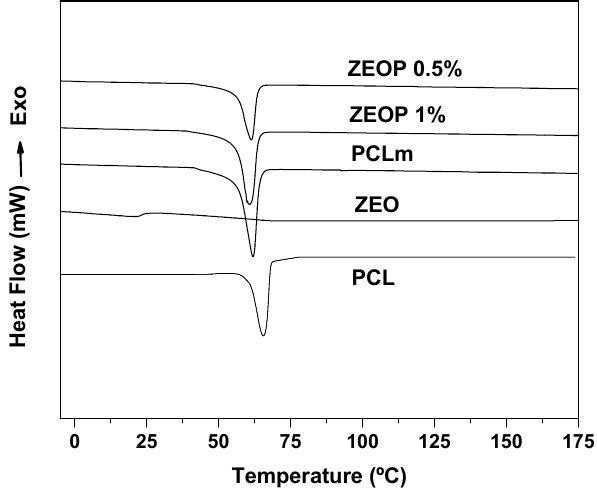
Figure 2. Differential scanning calorimetry thermograms corresponding to PCL, PCL matrix ZEO, ZEOP 0.5 % and ZEOP 1% formulations. (PCLm), ZEO, ZEOP 0.5 % and ZEOP 1% formulations.